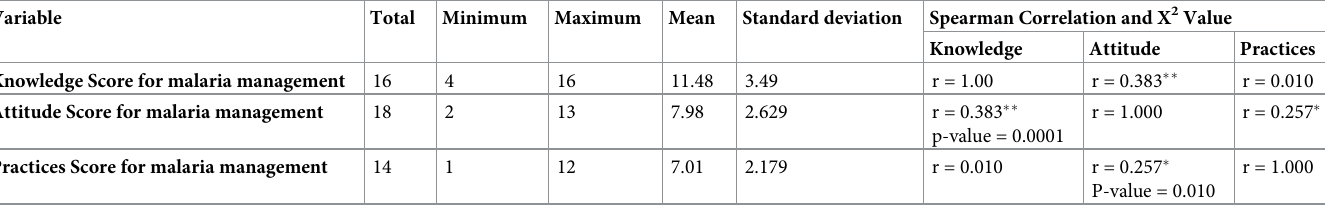
Table 6. Descriptive statistics for KAPs of CHWs regarding the management of childhood malaria.